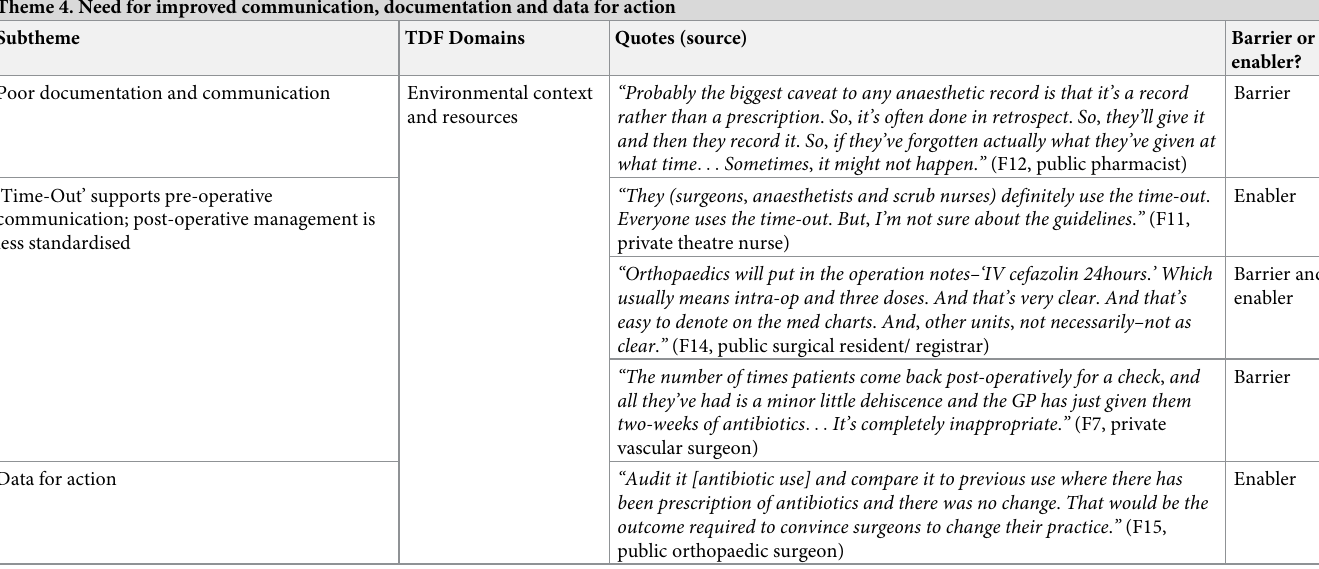
Table 6. Representative quotations from Theme 4, reflecting ‘Physical Opportunity’ of the COM-B model. Theme 4. Need for improved communication, documentation and data for action